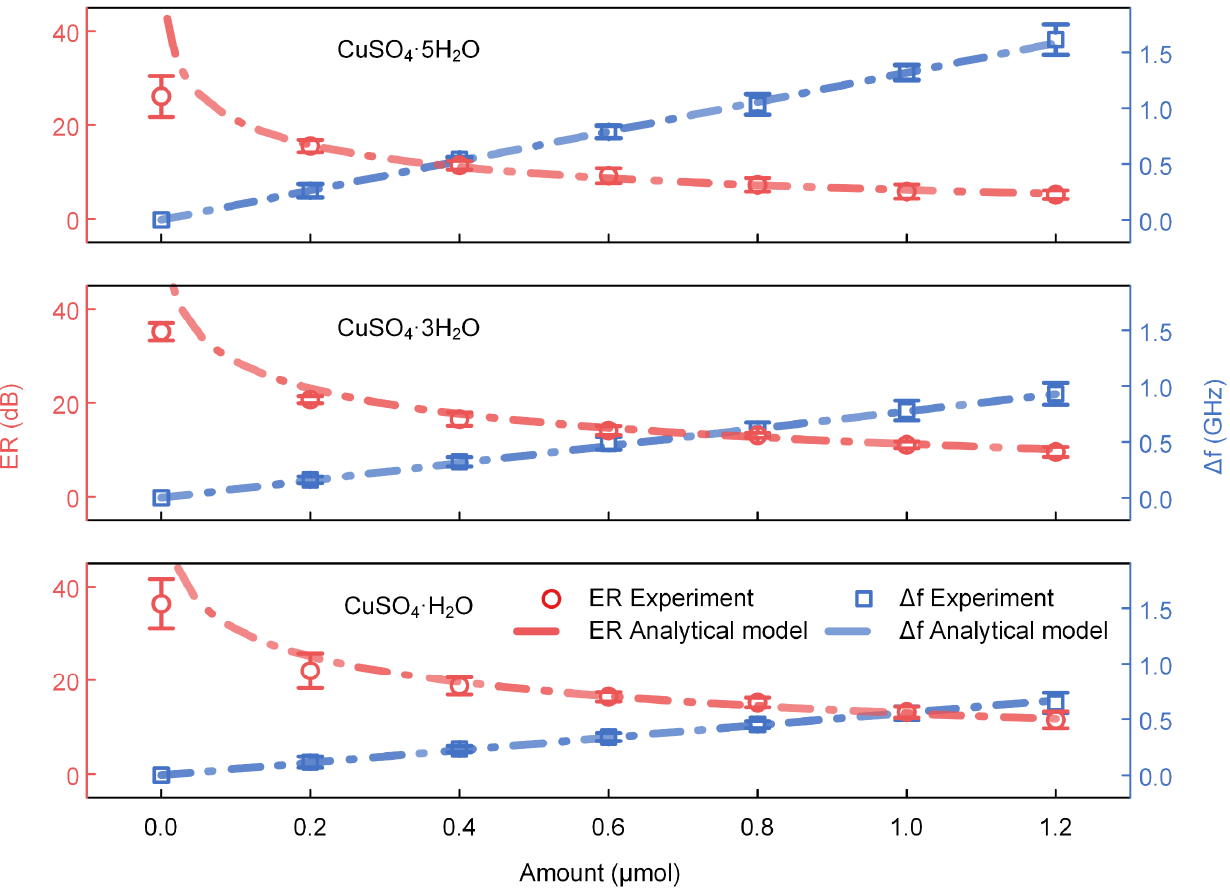
Figure 3. The experimental results (dots) and fitting results (lines) for different amounts of CuSO 4 · xH 2 O (x = 5, 3, 1). The red and blue dots (curves) represent the ERs and frequency shifts of the resonance dip, respectively.